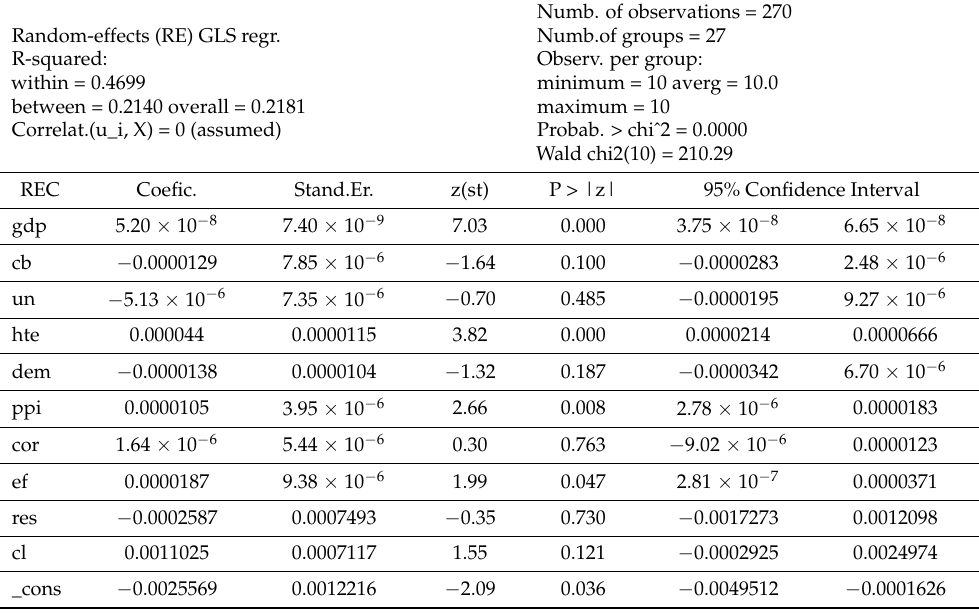
Numb. of observations = 270 Numb.of groups =